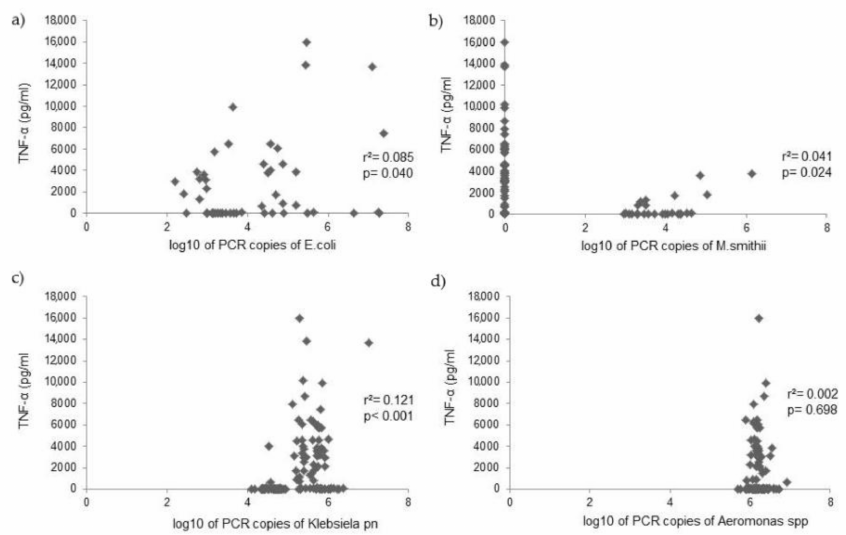
Figure 4. Correlation between TNF- α levels and PCR copies of ( a ) Escherichia coli , ( b ) Methanobevribacter smithii , ( c ) Klebsiella pneumoniae , and ( d ) Aeromonas spp. in the duodenal